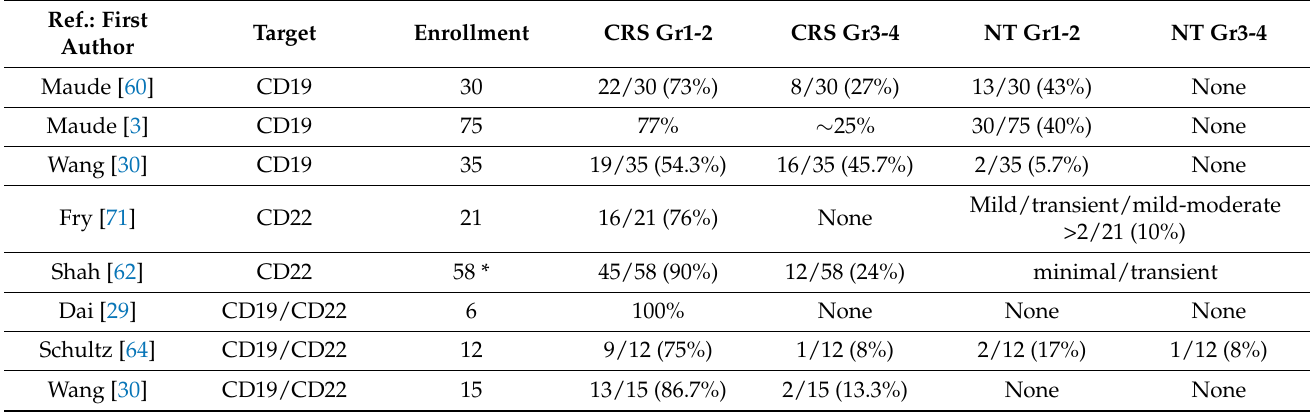
Table 6. Comparing CRS and NT in dual-targeting CAR T-cell therapy with Si-CAR-T therapy in